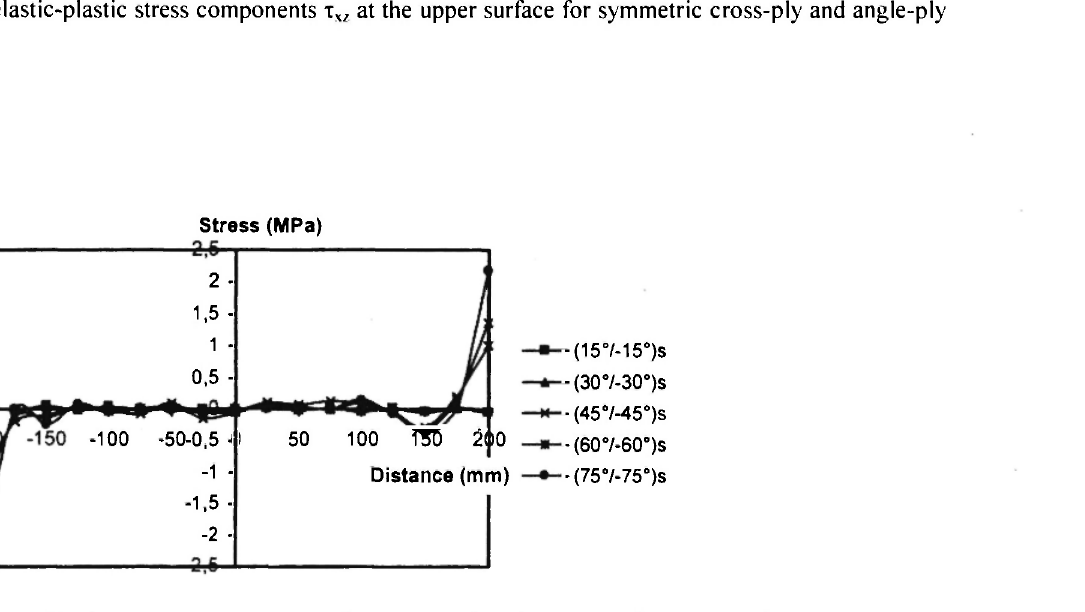
Fig. 10: Variation of the residual stress component τ χζ at the upper surface for symmetric angle-ply laminated